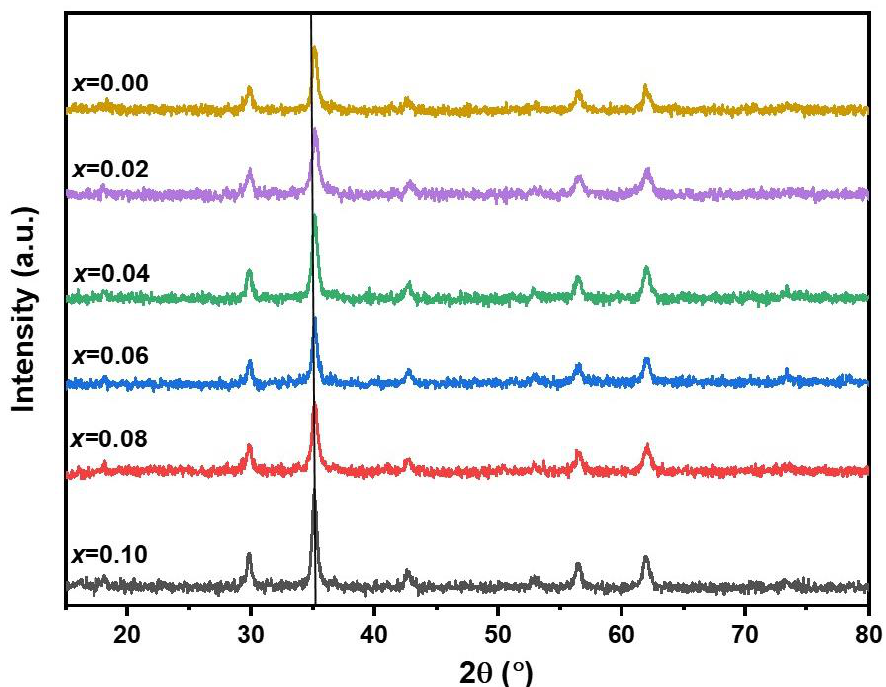
Figure 3. X-ray diffraction patterns of Mn 0.6 Zn 0.4 Eu x Fe 2 − x O 4 ( x = 0.00, 0.02, 0.04, 0.06, 0.08, 0.1). Table 1. Crystallite sizes, lattice constants, saturation magnetizations ( M s ) and Curie temperatures (T c ) of the EuMZF nanoparticles with citric acid coating and with different values of substitutions